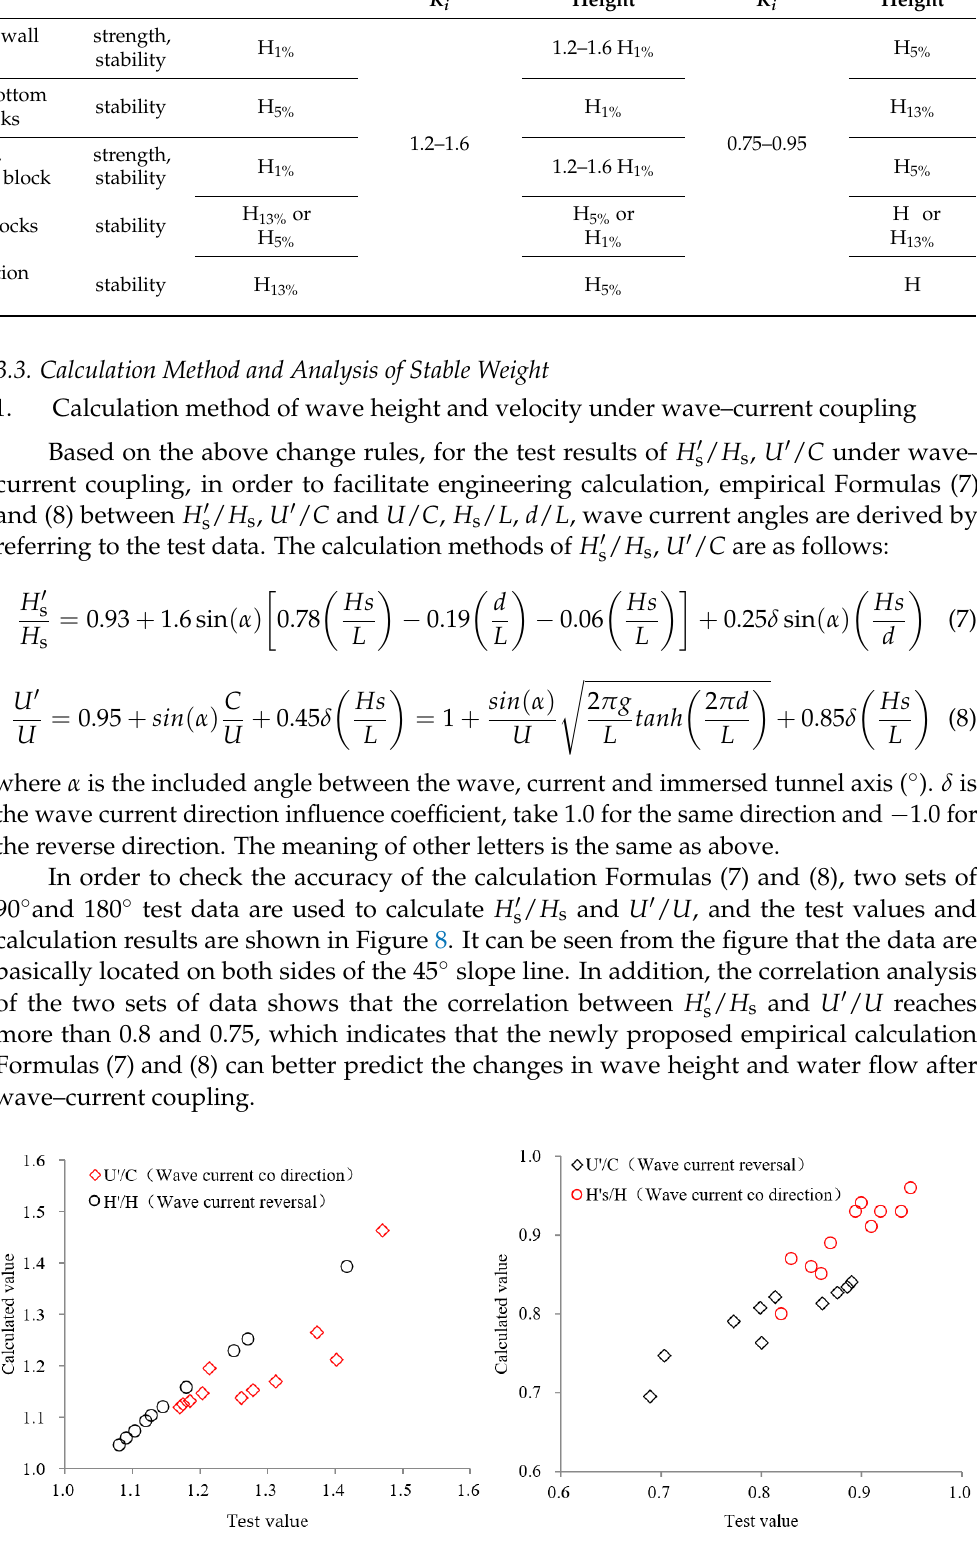
Figure 8. Verification results of test values and calculated values.